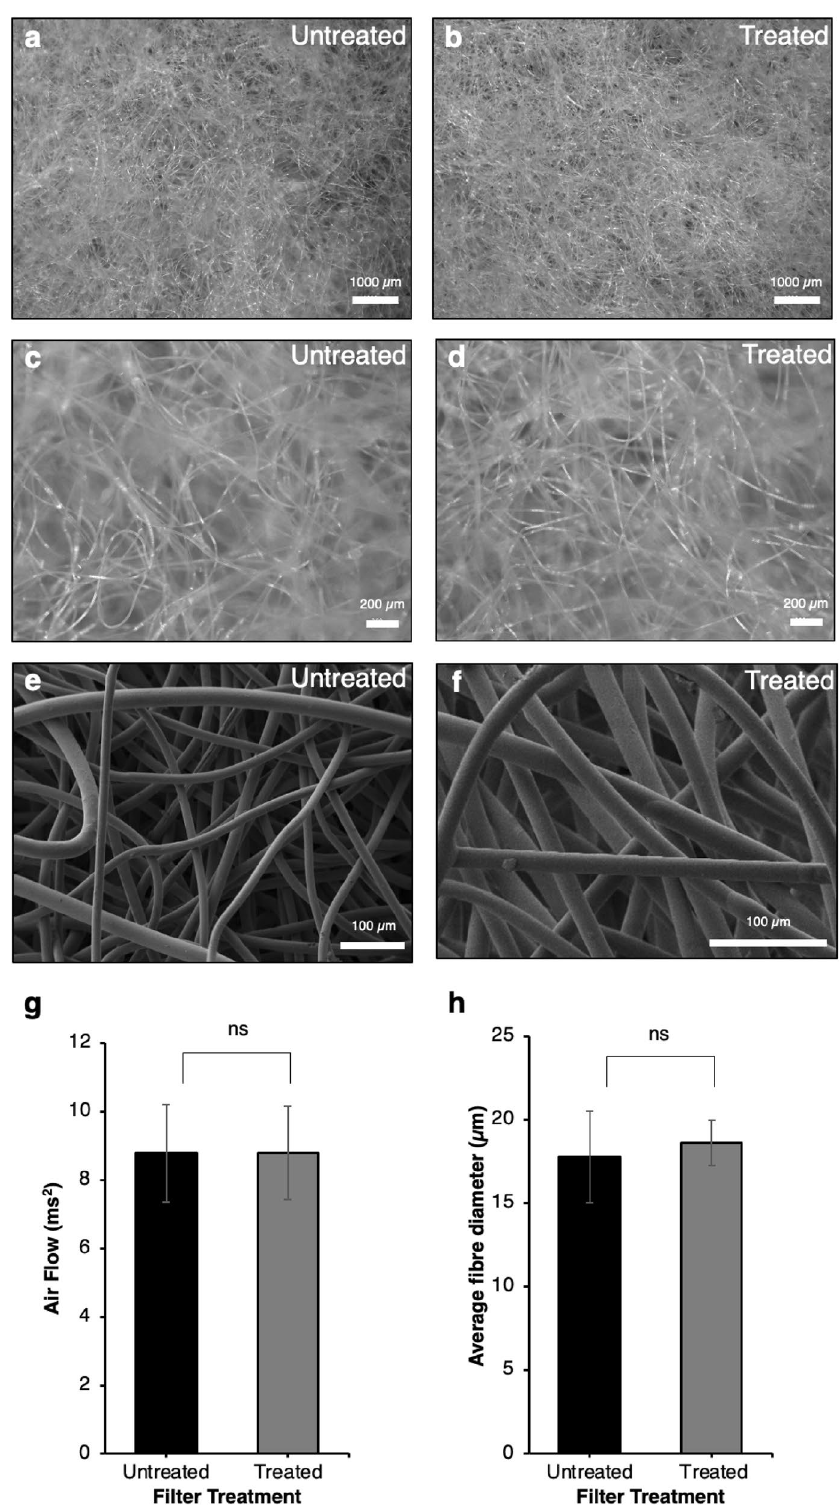
Figure 1. Characterisation of CHDG treated filters. ( a ) Light microscopy of an MK3 filter at ×3.5 magnification. Image is representative of all images, scale bar 1000 μm. ( b ) Light microscopy of treated antimicrobial filter at ×3.5 magnification. Image is representative of all images, scale bar 1000 μm. ( c ) Light microscopy of an MK3 filter at ×64 magnification. Image is representative of all images, scale bar 200 μm. ( d ) Light microscopy of treated antimicrobial filter at ×64 magnification. Image is representative of all images, scale bar 200 μm. ( e ) low magnification SEM images of MK3 filter, image is representative of all images, scale bar 100 μm ( f ) SEM images of antimicrobial filter, image is representative of all images, scale bar 100 μm ( g ) Graph shows the average rate of air flow through standard and antimicrobial filters, n = 12, error bars show standard error of the mean. ( h ) Graph shows the average fibre diameter of untreated and treated filters, measured from SEM images, n = 51, error bars show standard error of the